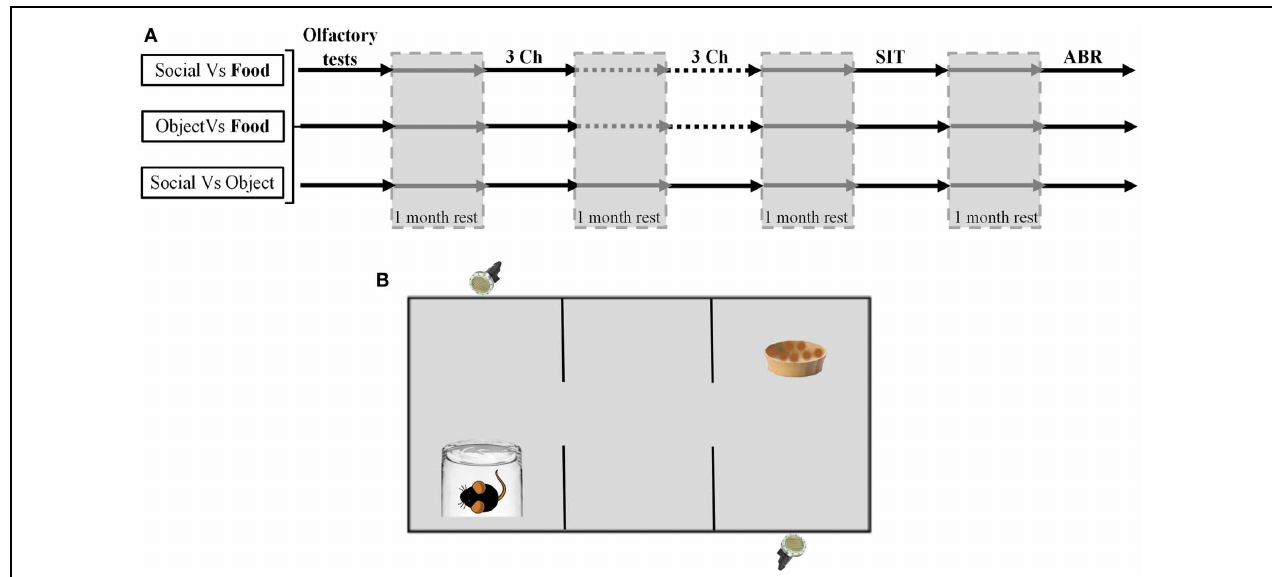
periods. (B) Schematic representation of the three chambers task. Each reward was placed at the opposite of the microphones. Two microphones placed above the cage allowed the recording within only one